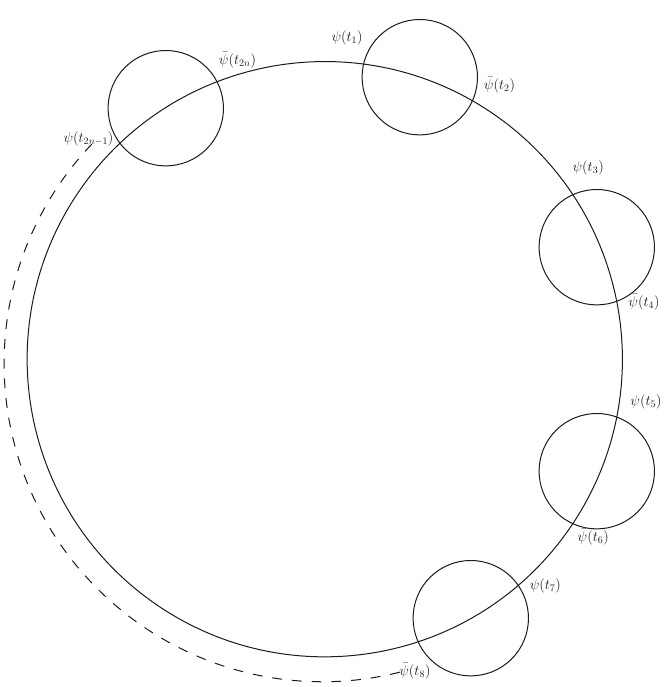
Figure 6 . Free energy diagram with n